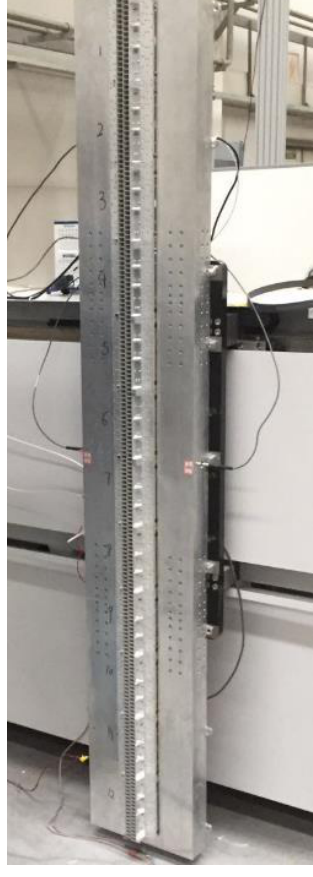
Figure 5. Imaging system.